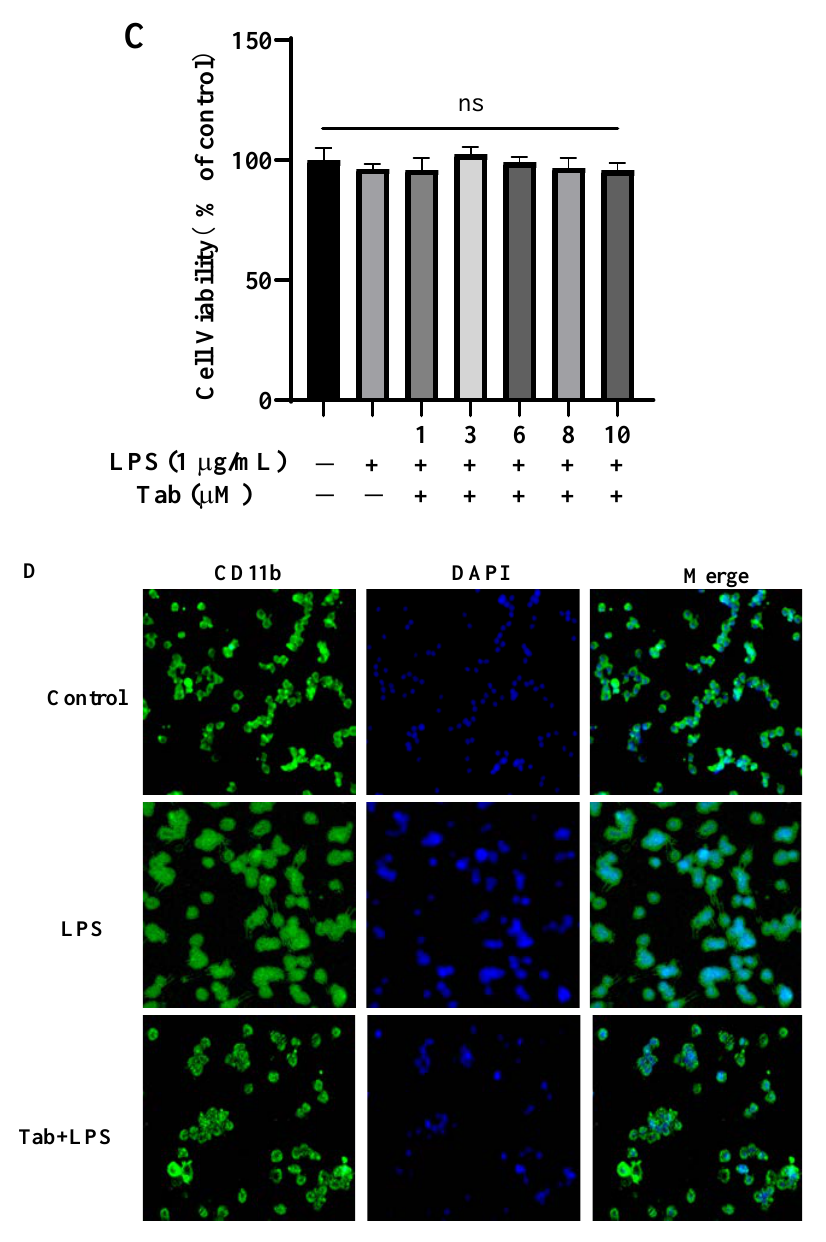
Figure 1. Effect of Tab on the viability of BV2 cells. ( A ) The chemical structure of Table ( B ) BV2 cells were treated with 0, 1, 3, 6, 8, 10, and 20 μM Tab for 24 h. ( C ) The cells were treated with 0, 1, 3, 6, 8, and 10 μM Tab for 4 h, then treated with LPS (1 μg/mL) for 24 h. The cell survival rate was determined by CCK-8. ( D ) Microglial activation was visualized by immunostaining with an anti-CD11b antibody. *** p < 0.001 vs. control cells.